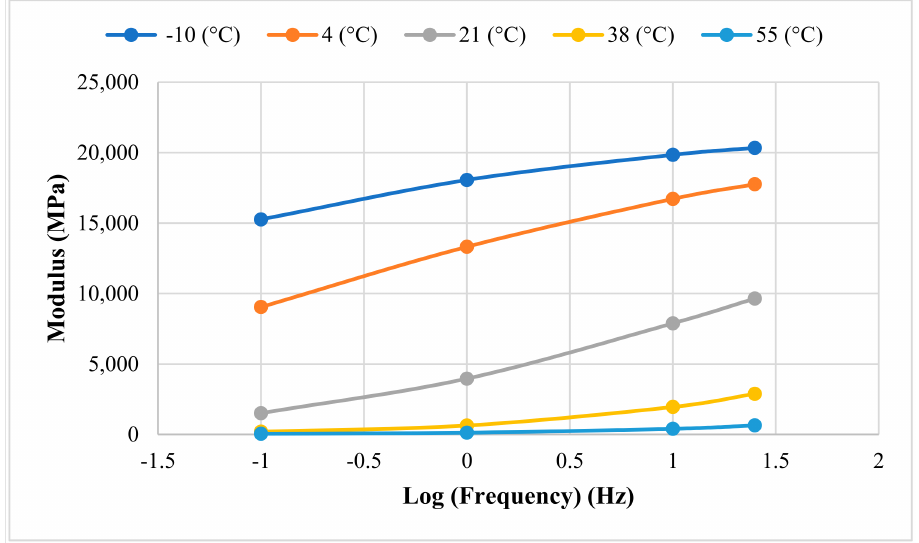
Figure 5. Dynamic modulus of asphalt mixture for